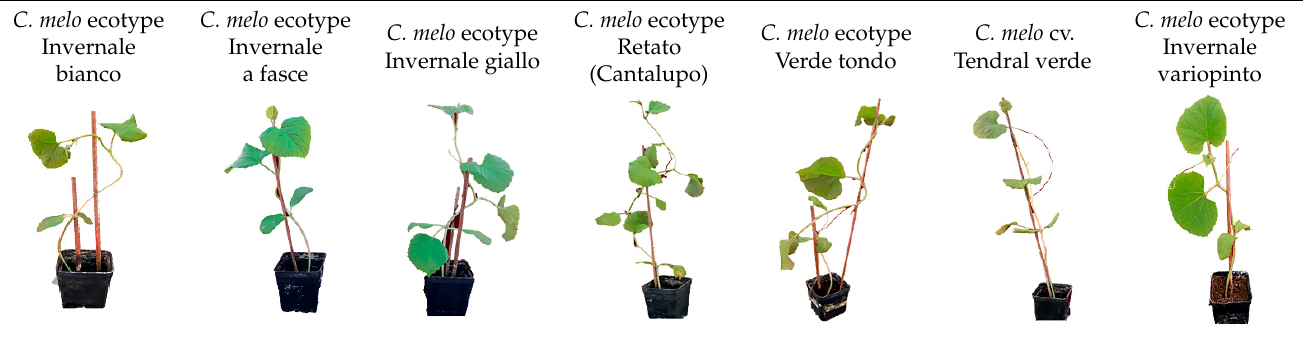
Table 3. List of different Cucurbita genotypes subjected to ToLCNDV-Le mechanical transmission.